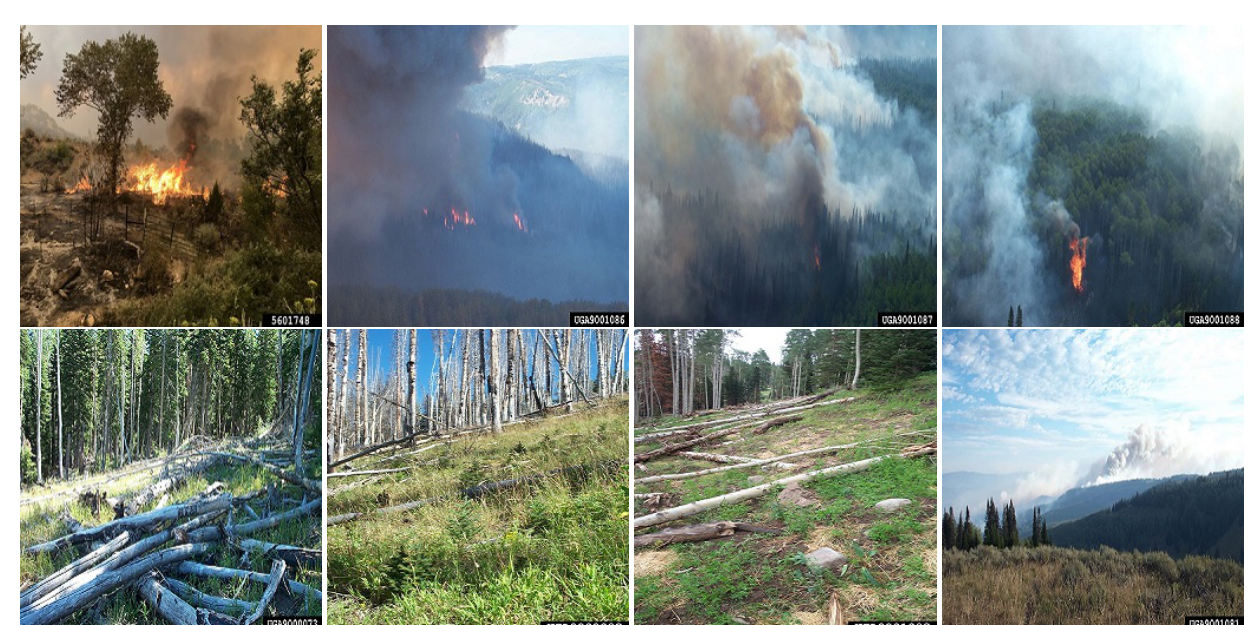
Figure 10. Examples from the ForestryImages dataset. ( Top ): Fire images; ( Bottom ): non-fire images.